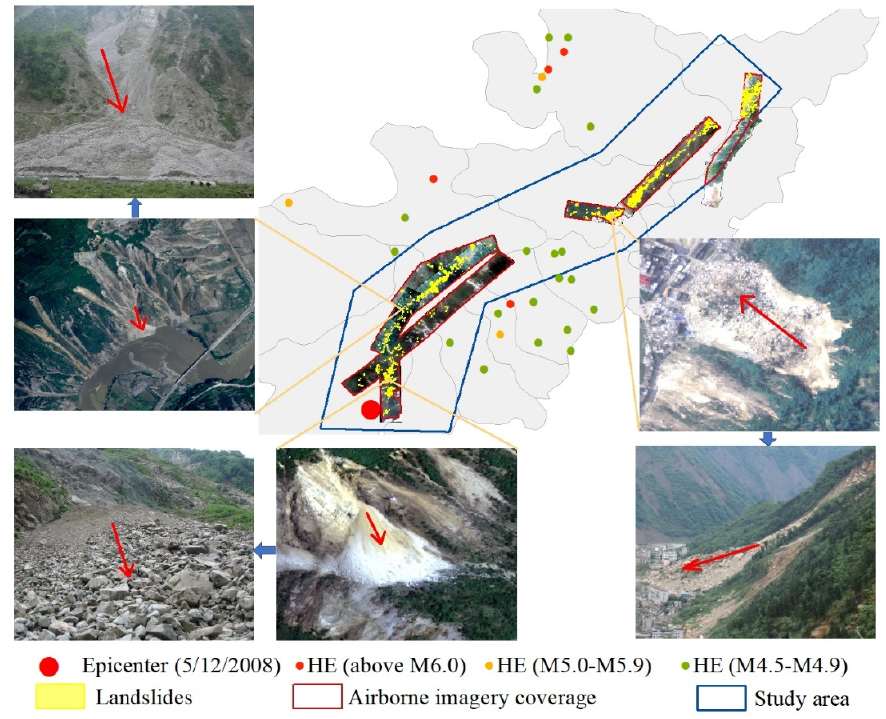
Figure 3. Locations and photographs of typical landslides. The abbreviation of HE represents of historical earthquake.